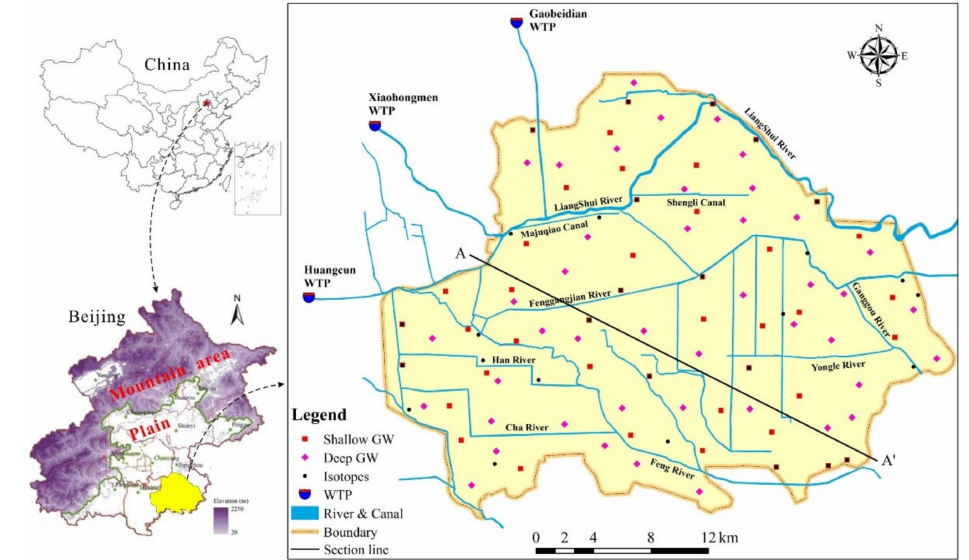
Figure 1. Location of the study area and sampling sites.